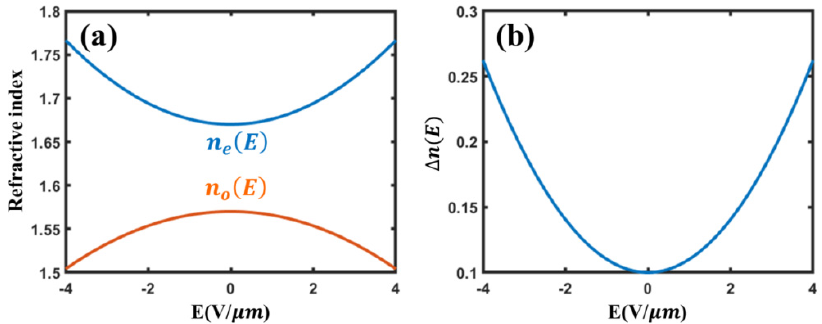
Figure 3. ( a ) Refractive index and ( b ) birefringence with applied electric field.